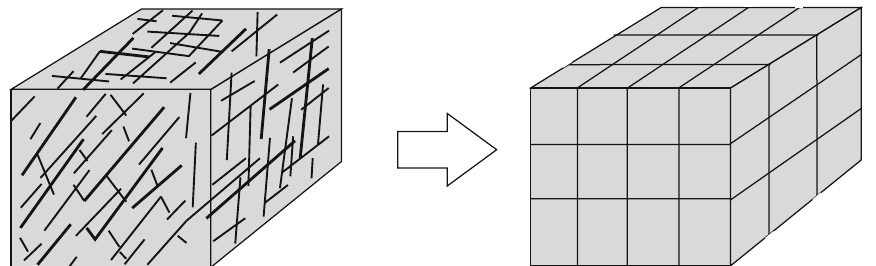
Figure 2: Schematic diagram of the discretized complex fracture model [14].